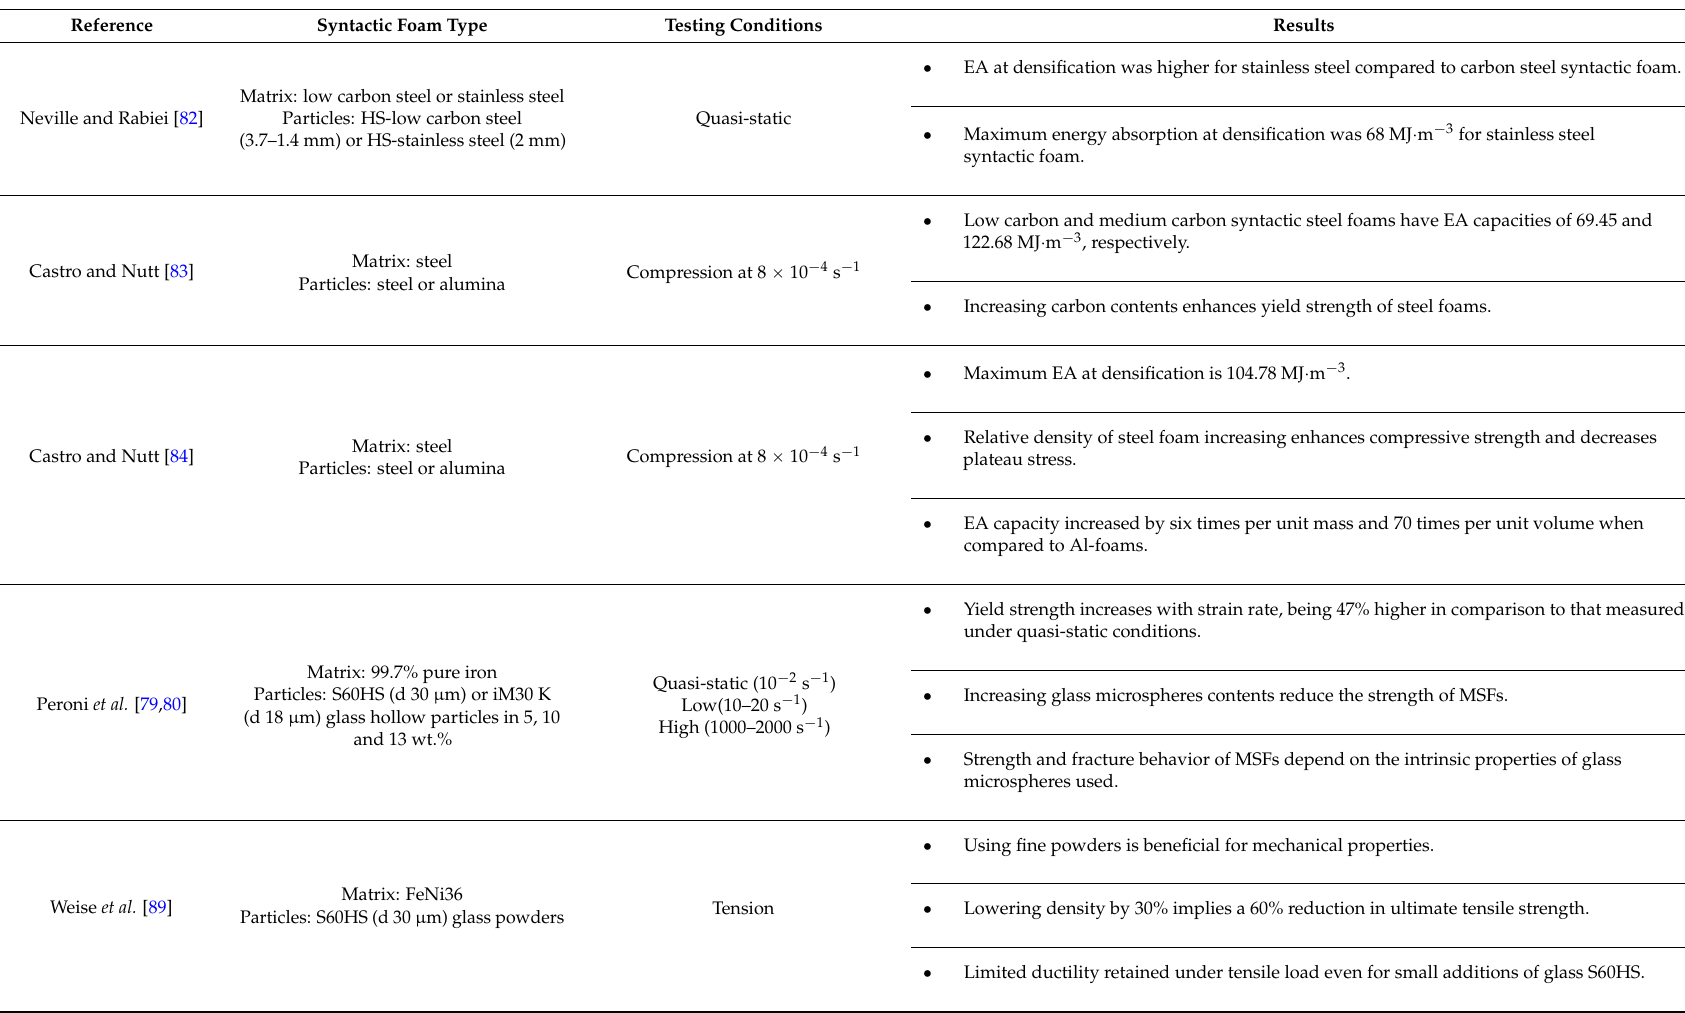
Table 5. Literature survey on iron or steel matrix syntactic